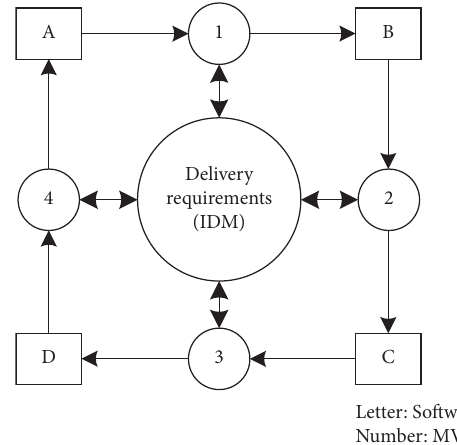
Figure 3: Information delivery between different software